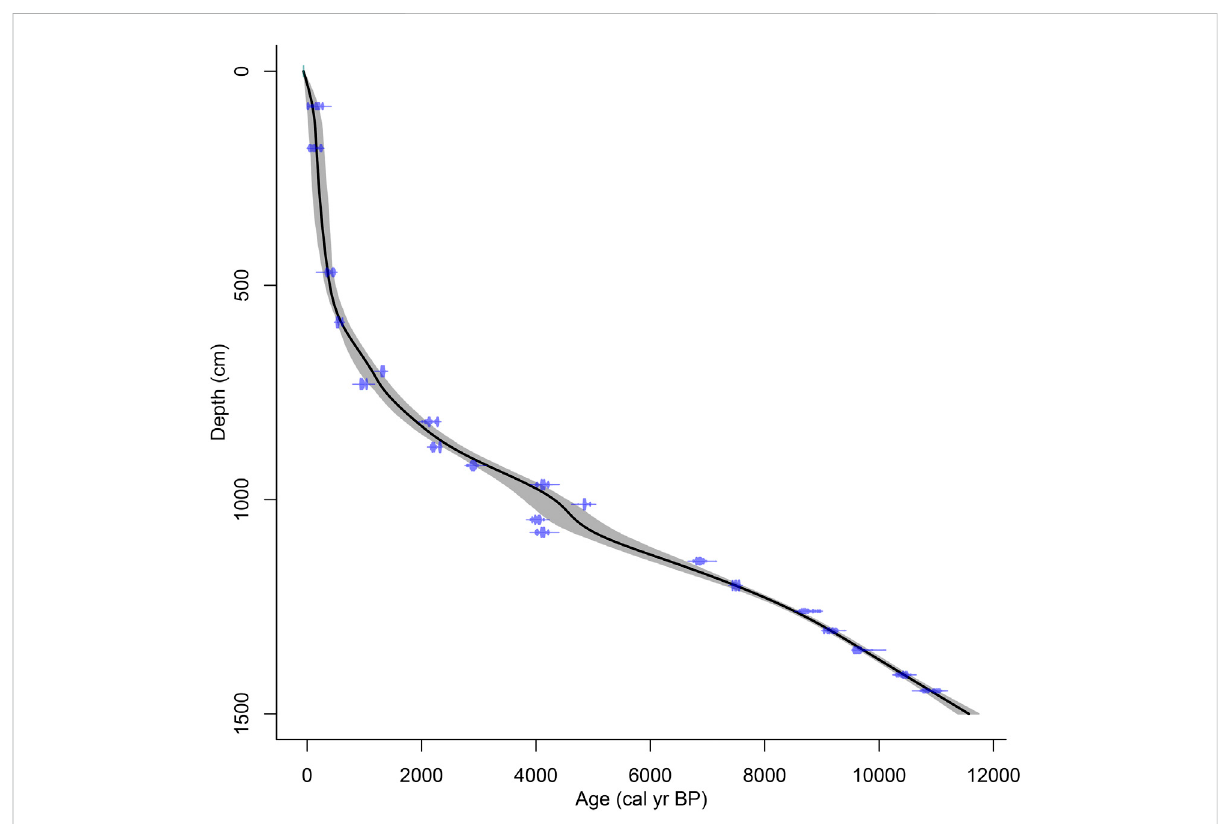
FIGURE 2 Age-depth model of the Lake Mayinghai core MYH14B [improved from Cheng et al.